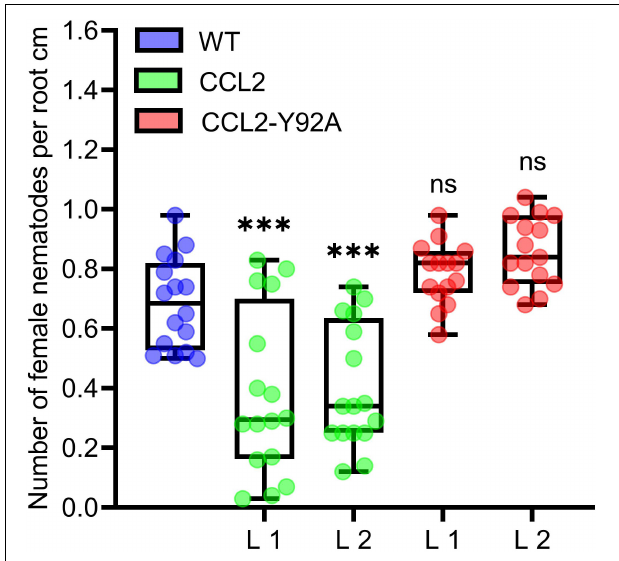
FIGURE 2 | Partial resistance of CCL2-expressing plants toward the cyst nematode H. schachtii . 12-day-old Arabidopsis seedlings (WT, CCL2, and CCL2-Y92A lines) were inoculated with 30 freshly hatched juveniles per plant and evaluated 14 dpi for number of female nematodes per root centimeter. Boxplots represent median and 1.5 times the interquartile range (WT and CCL2 lines n = 16; CCL2-Y92A n = 15; three independent experiments). Asterisks above columns indicate statistically significant differences ( ∗∗∗ P ≤ 0.001, ns, not significant) between CCL2 lines and WT plants, analyzed by one-way ANOVA and post hoc analysis with Dunnett’s multiple-comparison